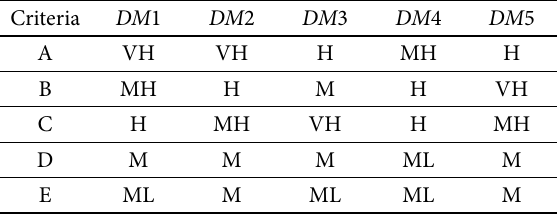
Table 4. Fuzzy weight and normalized weight Criteria